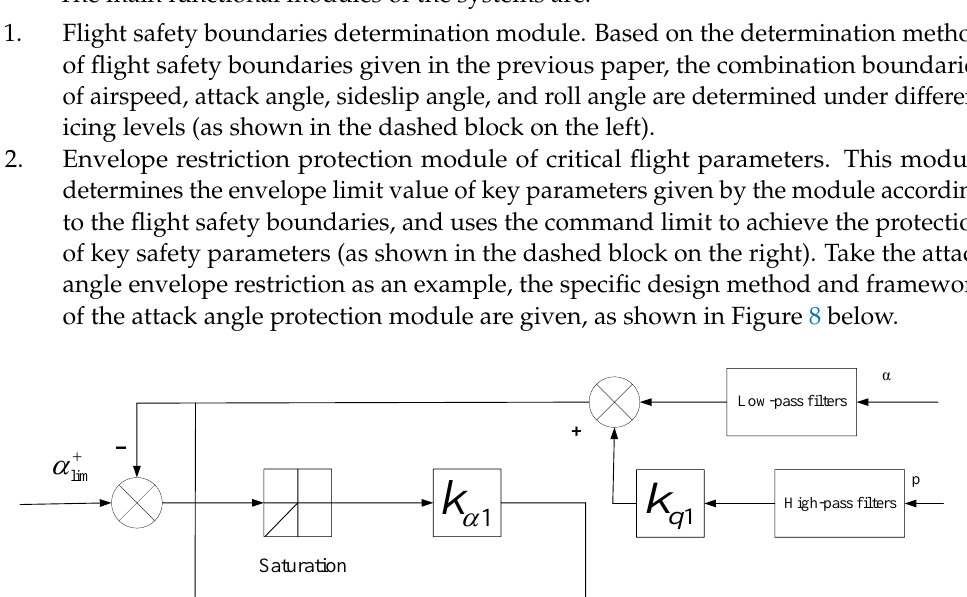
Figure 7. Framework of icing flight safety boundaries protection system based on neural network adaptive dynamic inverse.